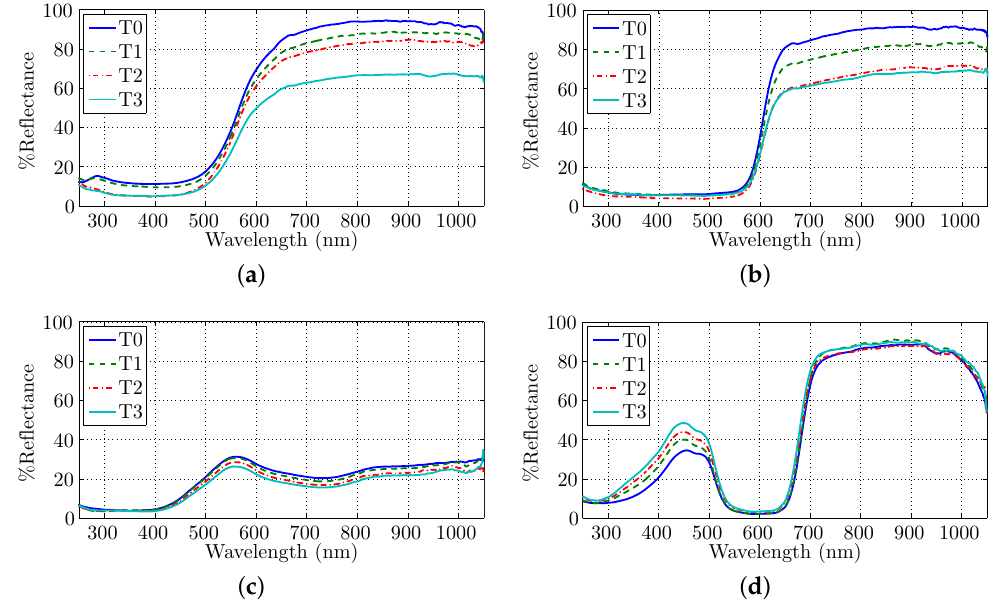
Figure 4. UV/Vis spectrum at the different aging steps for ( a ) yellow of Naples, ( b ) cinnabar, ( c ) green earth, and ( d ) cobalt blue pigments.